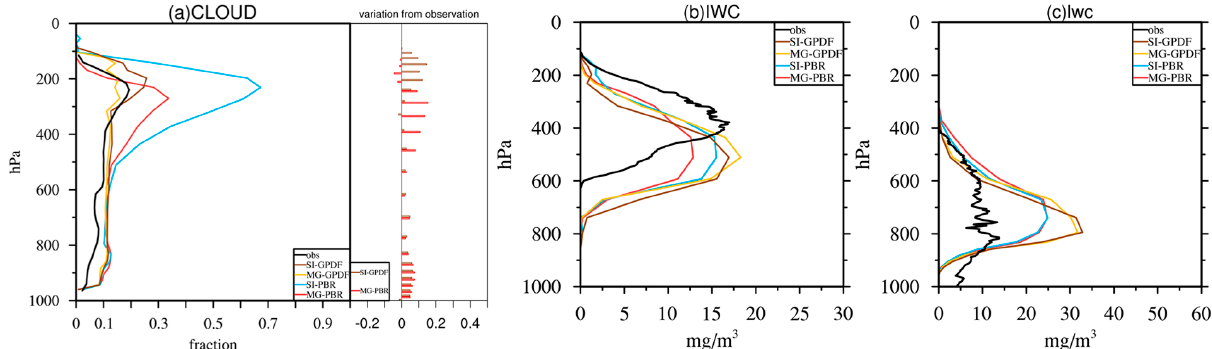
Figure 6. Vertical profiles of cloud fraction and the deviation from the observation ( a ), ice water content ( b ) and liquid water content ( c ) averaged during 19 June and 17 July in the four tests, MG-PBR (red), SI-PBR (cyan), MG-GPDF (orange), and SI-GPDF (brown) in comparison with the observations (black).